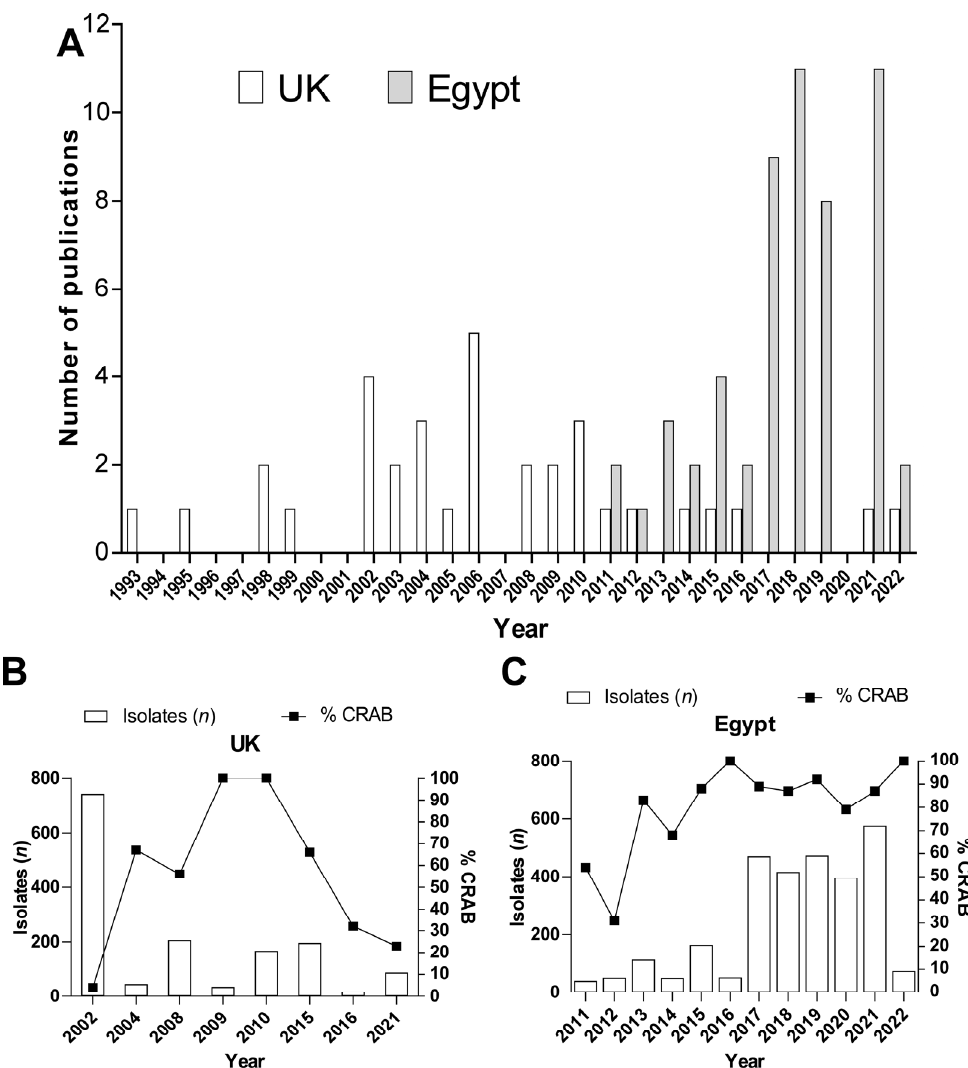
Figure 2. The trends of A. baumannii data in both the UK and Egypt. ( A ) Comparison of the frequency of A. baumannii studies in PubMed and Web of Science from the UK (open bars) and Egypt (gray bars) from 1993 to 2022. ( B ) The trends in the changes in the number of isolates detected per year (open bars) and the rate (%) of CRAB isolates within those collected (black boxes) in the UK. ( C ) The trends in the changes in the number of isolates detected per year (open bars) and the rate (%) of CRAB isolates within those collected (black boxes) in Egypt. The studies that were included in B and C are those that covered at least 10 isolates and have reported data about carbapenems susceptibilities.